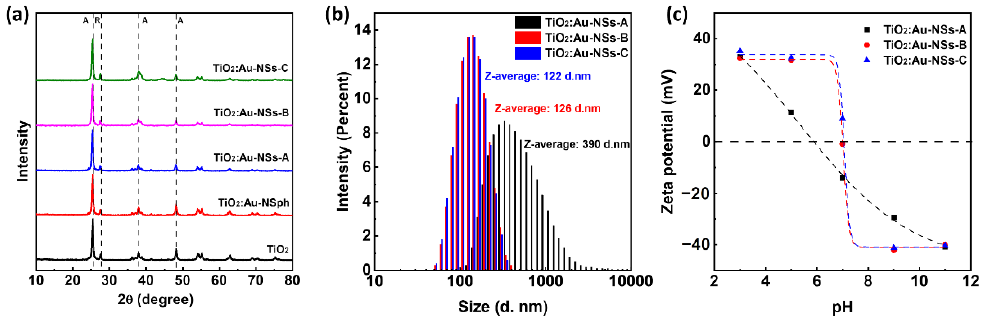
Figure 2. X-ray diffraction spectra of pristine TiO 2 , TiO 2 :Au-NSph, TiO 2 :Au-NSs-A, B, and C nanocomposites and identification of the representative diffraction peaks for anatase (A) and rutile (R) phases ( a ). The intensity size distribution of the TiO 2 :Au-NSs-A, B, and C nanocomposite and respective Z-average hydrodynamic size ( b ). Zeta potential measurements performed at different pHs (3, 5, 7, 9, and 11) for TiO 2 :Au-NSs-A, B, and C nanocomposite ( c ). This change in Au morphology affected the optical properties of the nanoparticles.